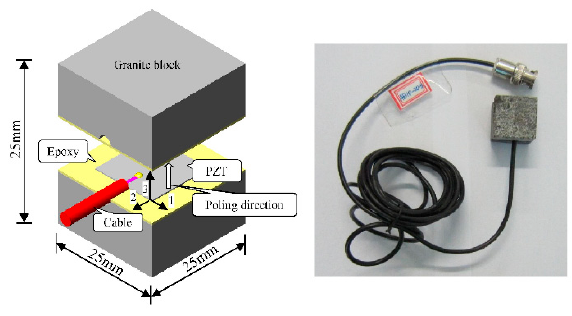
Figure 1. Illustration and photo of the SA.